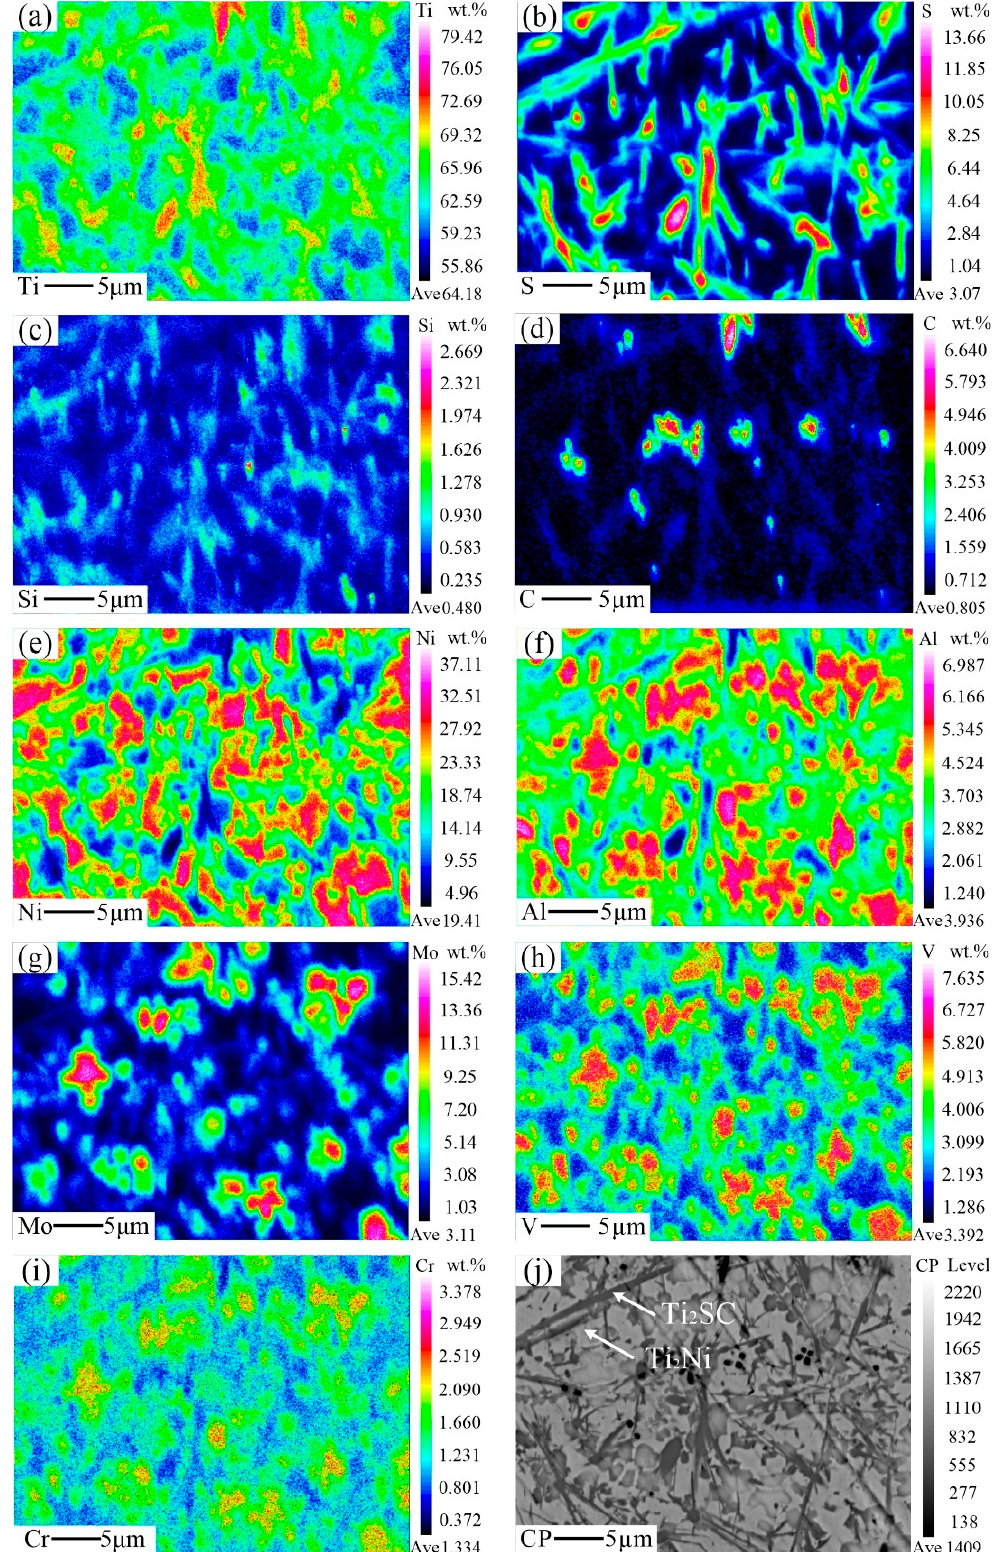
Figure 7. The EPMA analysis results of the coating: ( a ) Ti, ( b ) S, ( c ) Si, ( d ) C, ( e ) Ni, ( f ) Al, ( g ) Mo, ( h ) V, ( i ) Cr. ( j ) Backscattered electron image.